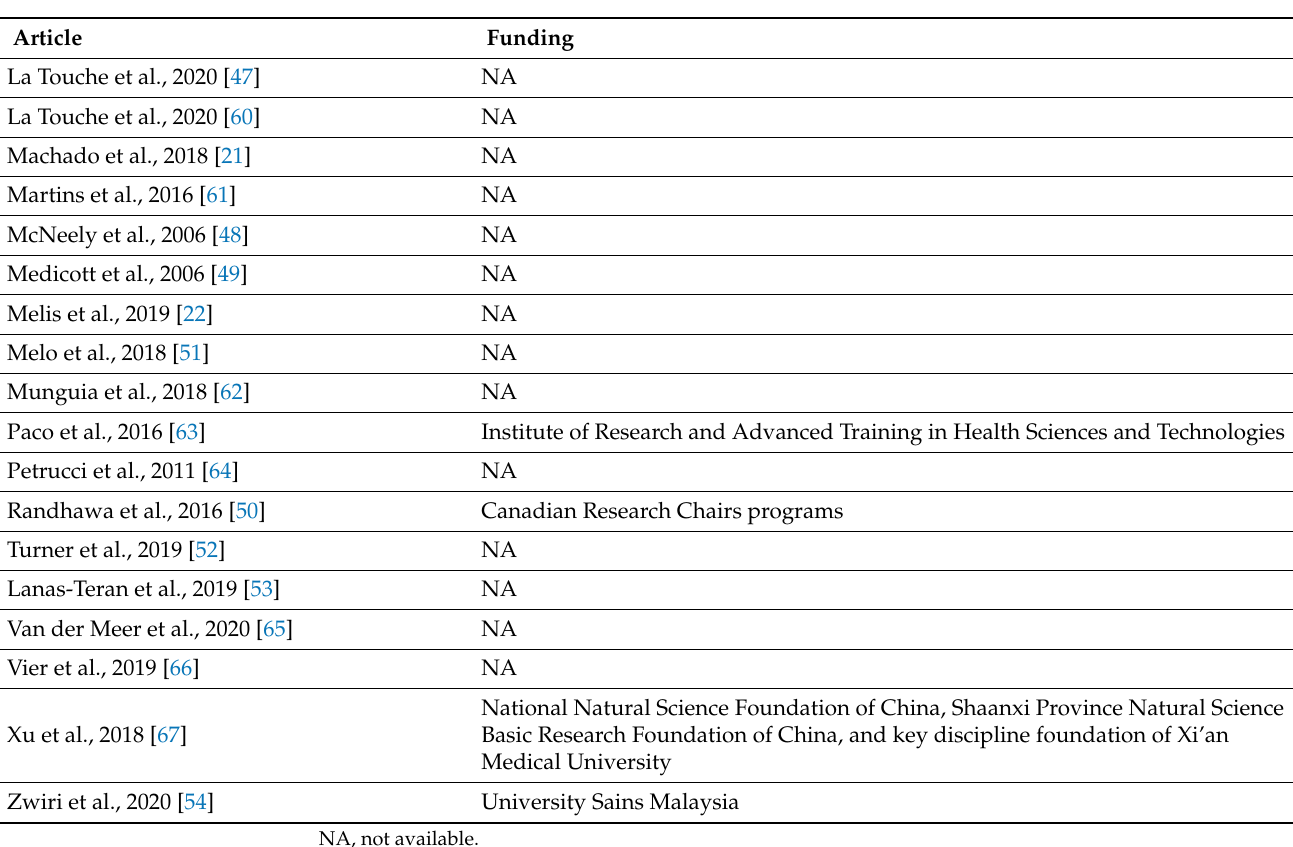
Table A4. Overlap of clinical trials of the MMA of combined manual therapy and therapeutic exercise interventions on pain